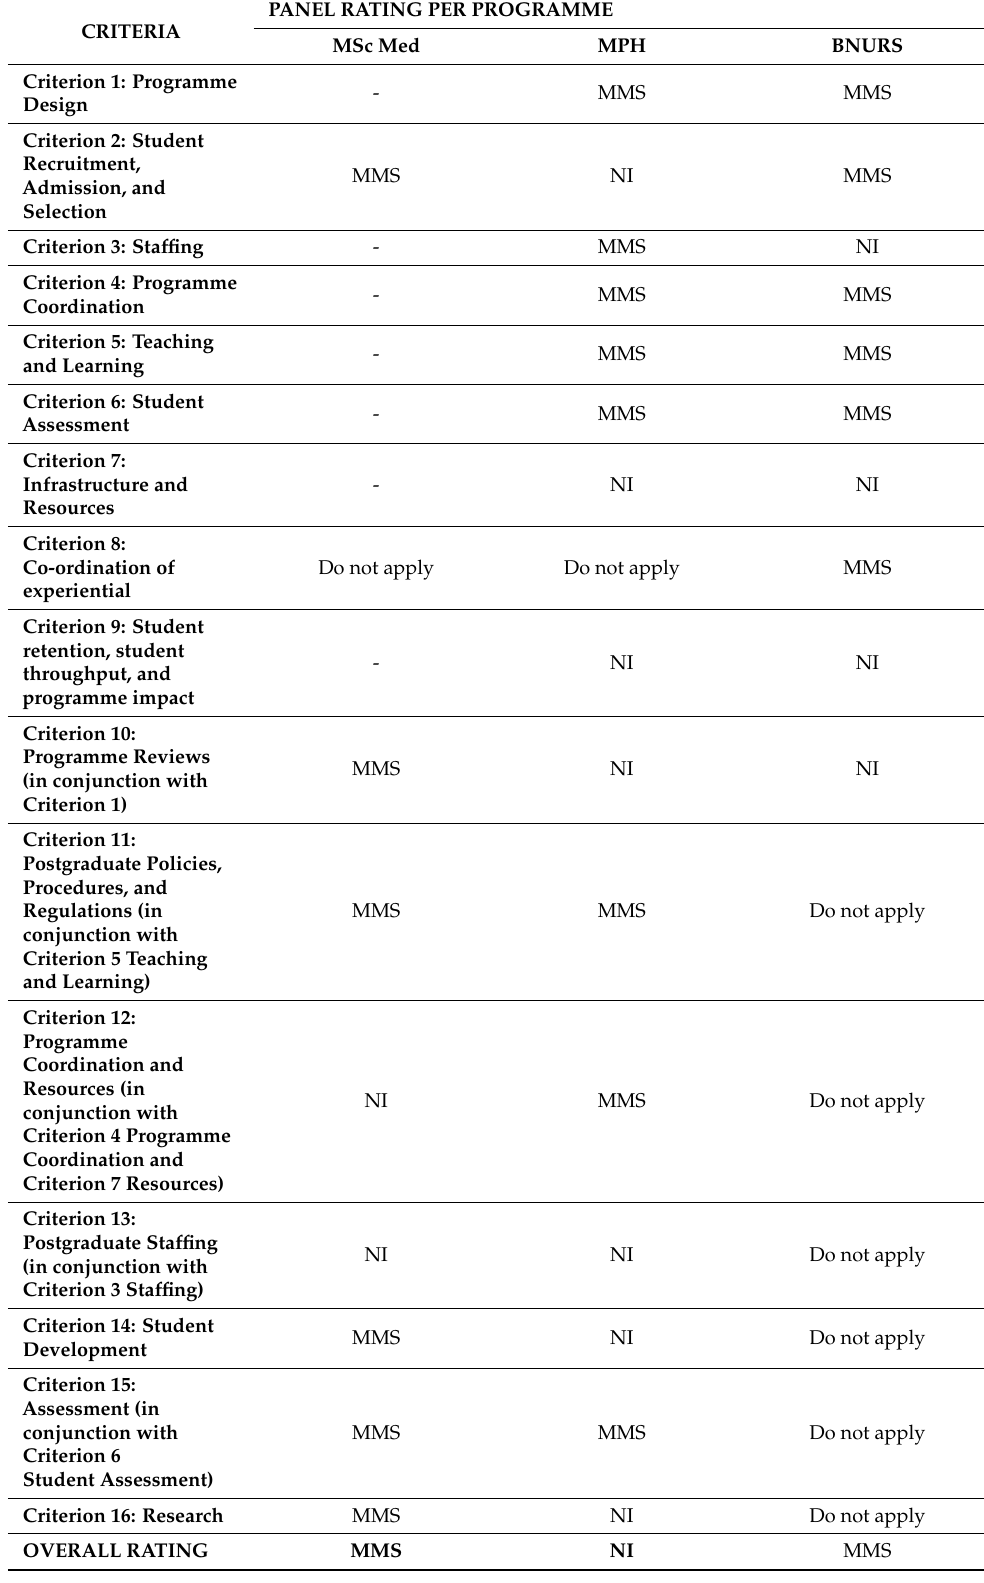
Table 1. Presents the results of the programme review per